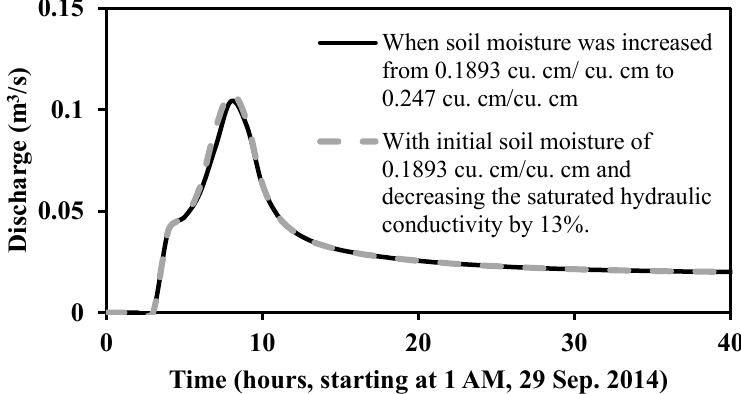
Figure 13. Reproducing similar hydrograph with 62% Nash–Sutcliffe efficiency.